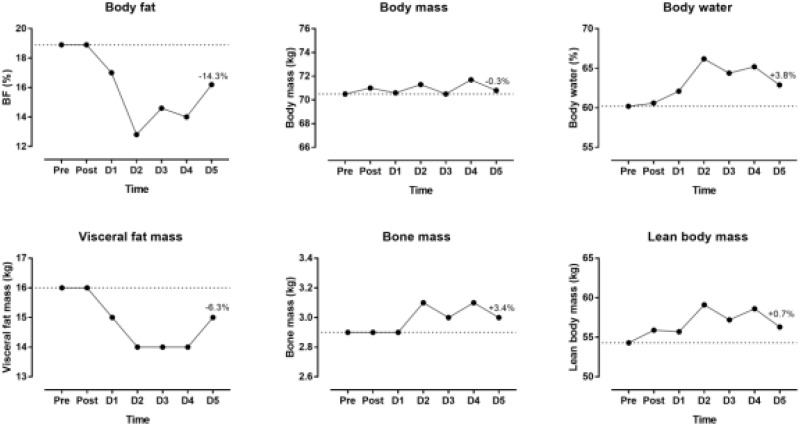
Body composition during the race and recovery. The dashed line represents the pre-race values. The percentage value over D5 point denotes change from post-race value. D, day post-race.